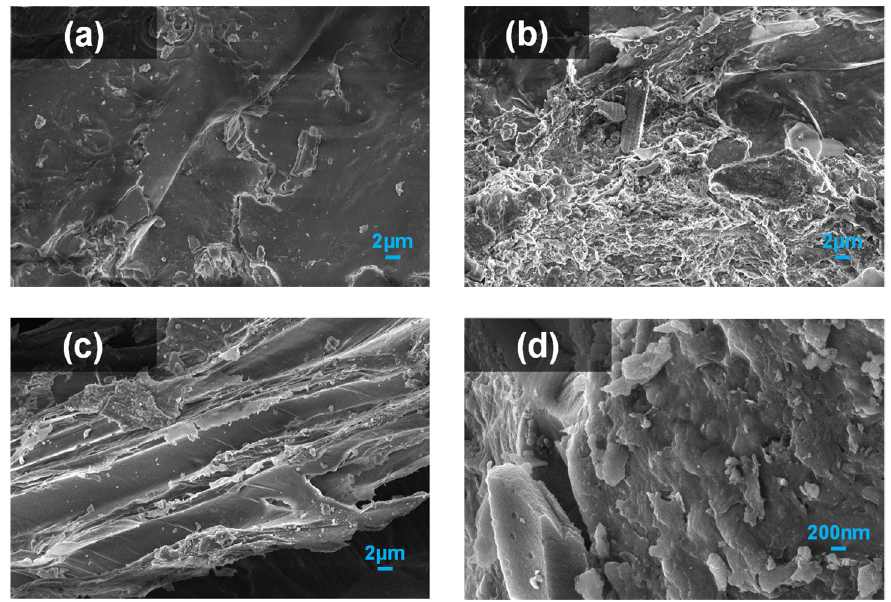
Figure 5. SEM images of corn stalk: ( a ) before anaerobic fermentation, after anaerobic fermentation without supplement ( b ) and with ( c ) B-4 and ( d ) A-5 as supplement.